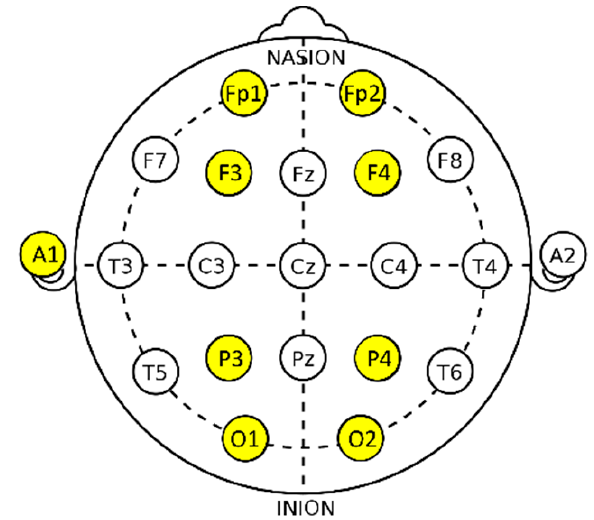
Figure 4. Measuring electrode. Fp: prefrontal cortex; F: frontal lobe; Temporal; C: central; P: parietal; O: occipital; Z: zero, refers to an electrode placed on the midline sagittal plane of the skull; A: the prominent bone process usually found just behind the outer ear.